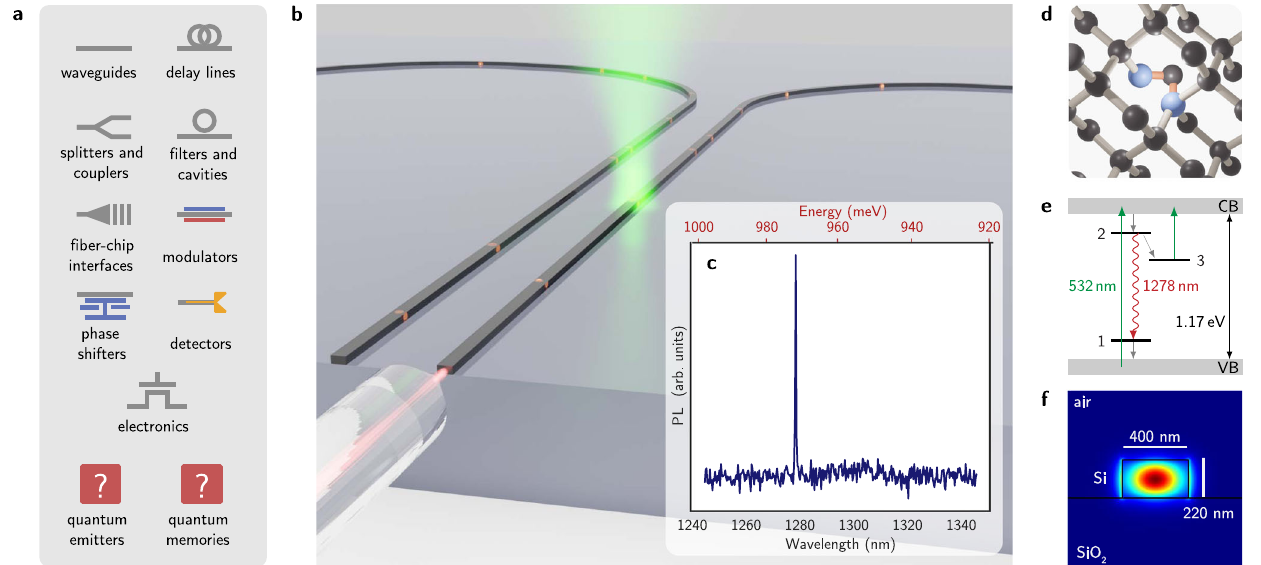
Fig.1|G-centersinsiliconphotonicsasascalablequantumphotonicplatform. a The silicon platform features technologically mature opto-electronics, but lacks integrated quantum emitters and memories. b Schematic showing our system, which integrates arti fi cial atoms (G-centers) in silicon photonic waveguides. c Measured G-center photoluminescence (PL) spectrum through our waveguide,